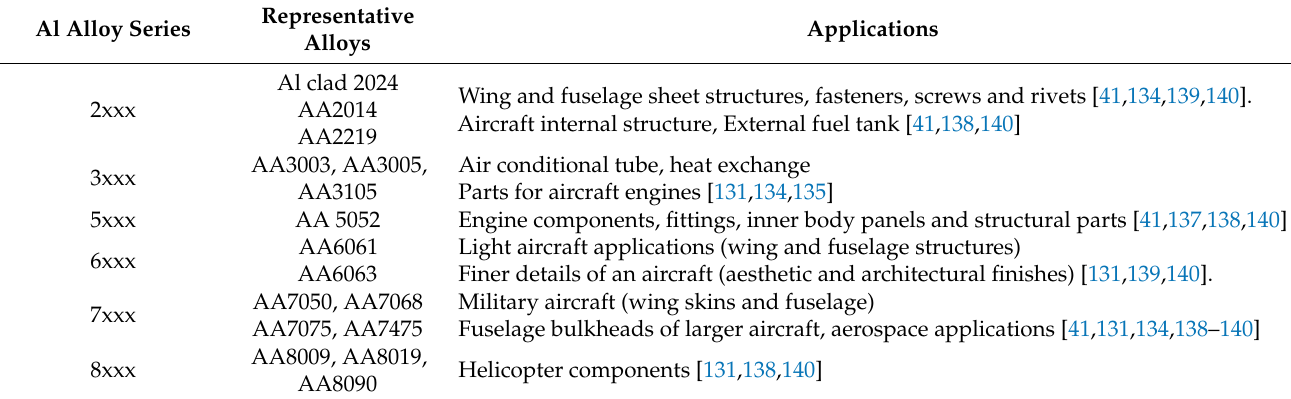
Table 1. The most commonly used Al alloys in aerospace applications.